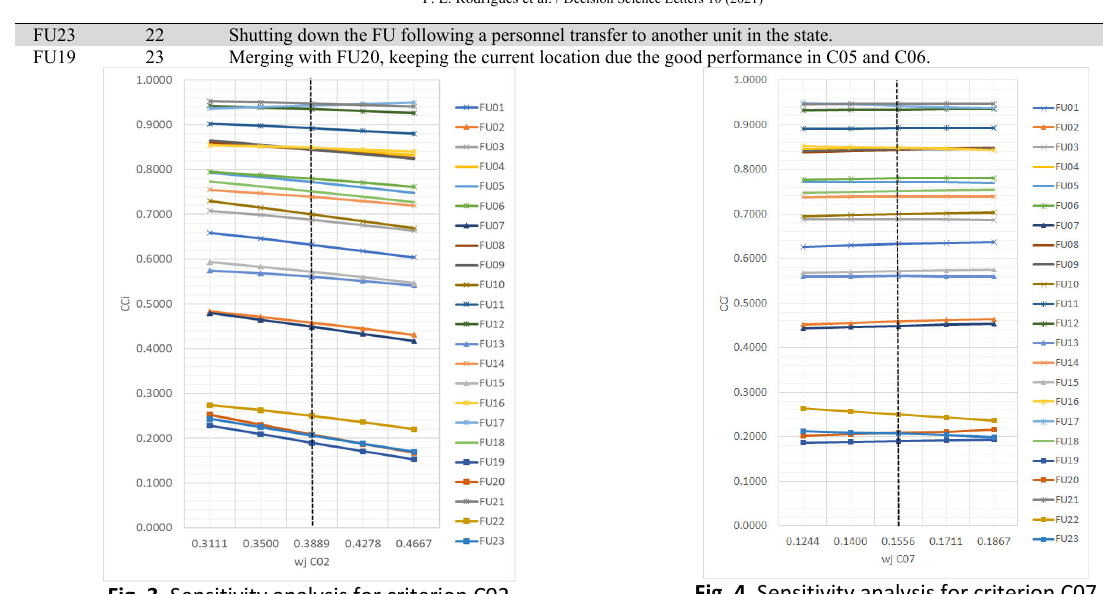
Fig. 3 . Sensitivity analysis for criterion C02 Fig. 4 . Sensitivity analysis for criterion